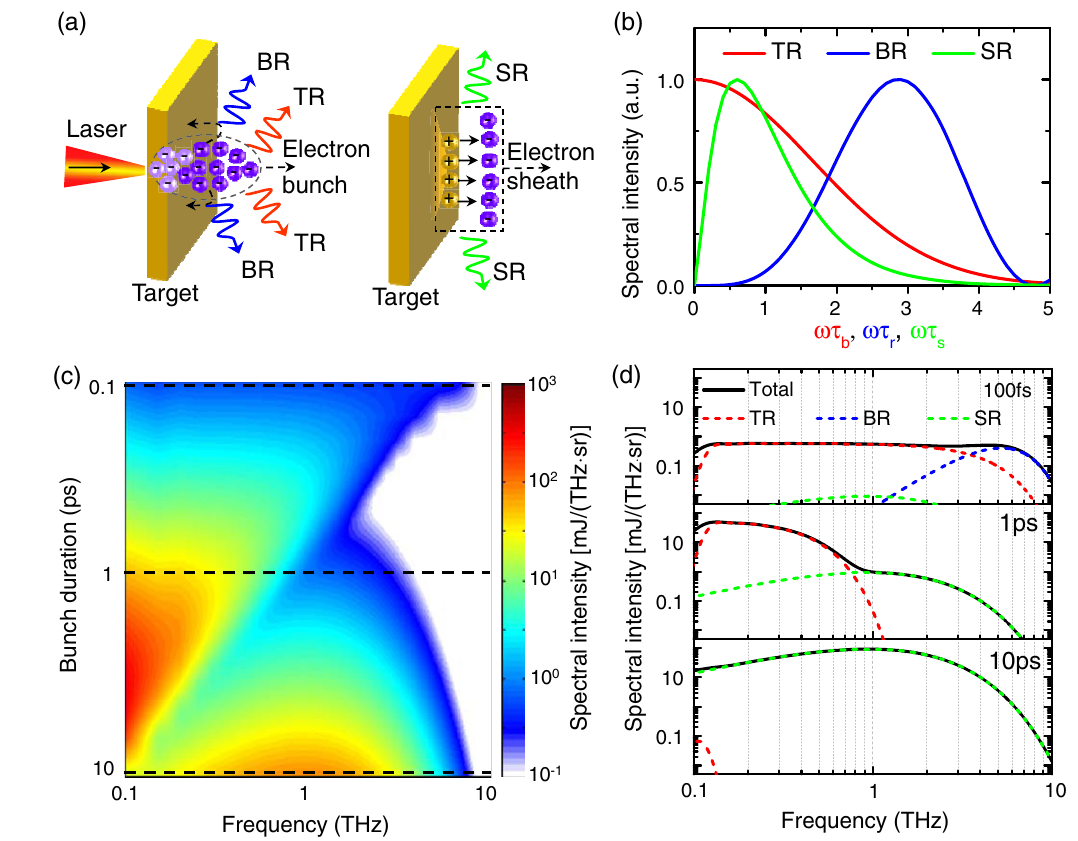
FIG. 1. Model illustration and theoretical projections. (a) Schematic illustration of the THz-generation scenarios at the rear side of a laser-irradiated foil. Left diagram: TR induced by escaping electrons and BR by electrons trapped in the sheath. Right diagram: SR induced by the time-varying electron sheath. (b) Spectral profiles for the TR (red) and the BR induced by a single electron (blue), and the SR (green). All curves are normalized to unity at their peaks. Here, τ b , τ r , and τ s in the horizontal axis refer to the electron bunch duration, half the dwell time of a single electron in the sheath, and the characteristic decay time of the sheath, respectively. (c) Resultant radiation spectra from TR, BR, and SR, calculated at given parameters (see Sec. VII), as a function of the electron bunch duration. (d) Three lineouts (at 100 fs, 1 ps, and 10 ps) taken from the spectral intensity map shown in panel (c). Dashed curves represent the individual spectral components from different radiation processes. The BR is too weak to appear on the 1-ps and 10-ps